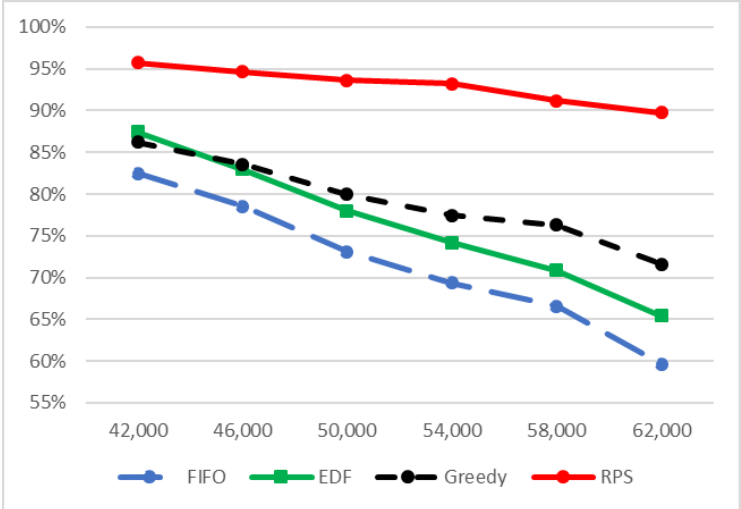
Figure 9. Percentage of cumulative reward with different arrival rates.